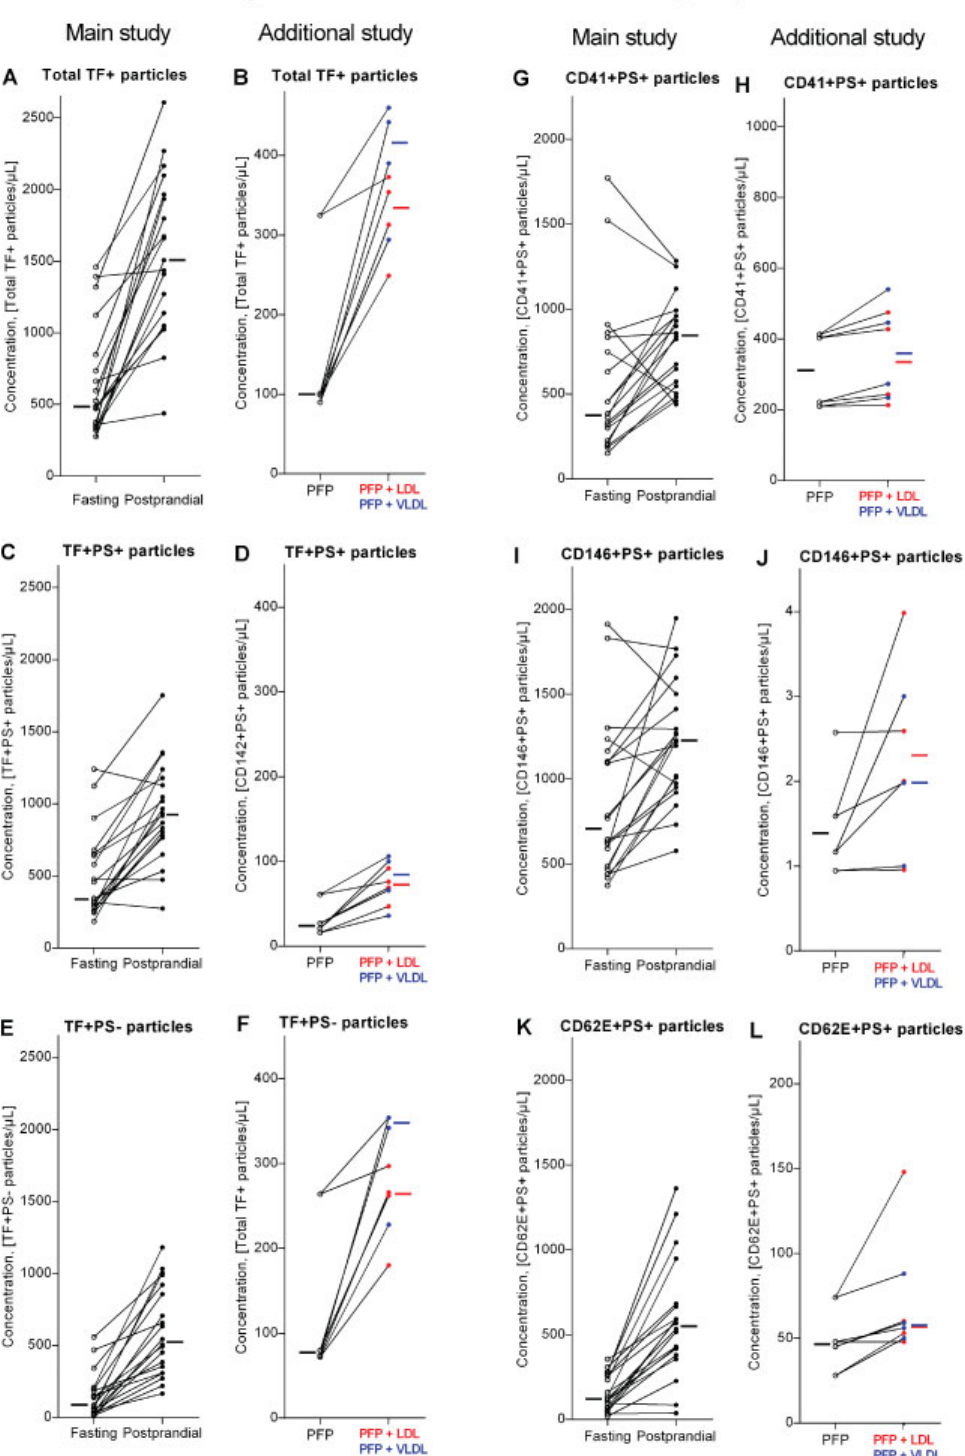
Fig. 2 Fasting and postprandial concentration of ( A ) total tissue factor-positive (TF þ ) particles, ( C ) TF þ phosphatidylserine-positive(PS þ ) particles, ( E ) TF þ phosphatidylserine-negative (PS (cid:2) ) particles, ( G ) CD41 þ PS þ particles, ( I ) CD146 þ PS þ particles, and ( K ) CD62E þ PS þ particles measured by fl ow cytometry. The results for the same particle subtypes before and after addition of VLDL or LDL to fasting plasma are shown in B , D , F , H , J (only three results for VLDL due to technical problems), and L , respectively. Lines combine fasting levels ( open circles ) with postprandial levels ( closed circles ) for each study participant, and for the additional study the levels before ( open circles ) and after addition of VLDL ( blue closed circles ) and LDL ( red closed circles ). Small bars to the left of the fasting and to the right of the postprandial results (or after addition of VLDL [ blue ] or LDL [ red ]) indicate the median of all